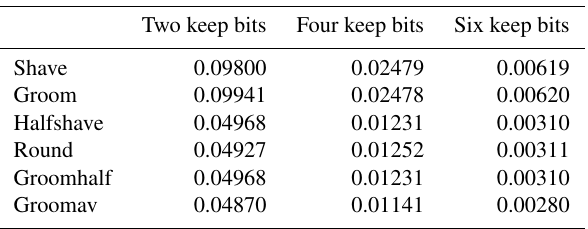
Table 2. NRMSE (normalized root-mean-square error) of the signal in Fig. 2a after trimming